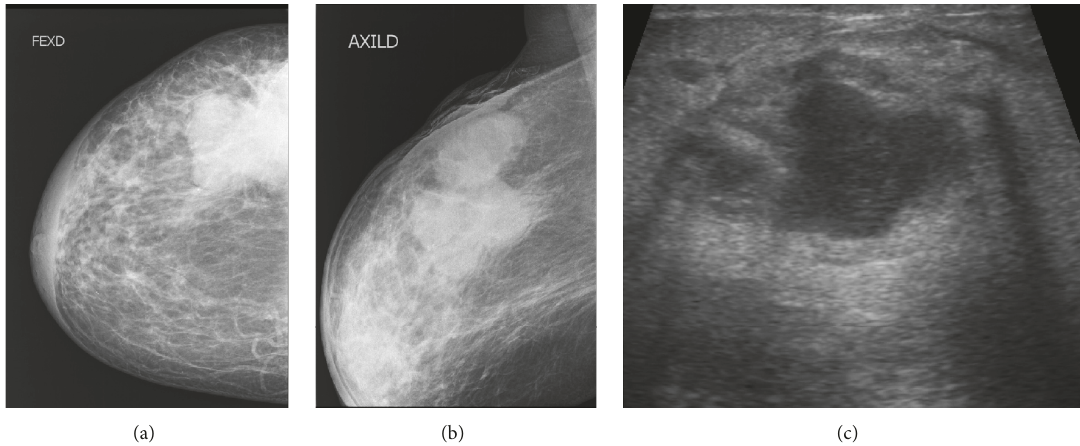
Figure 3: Mammogram images (a and b) presenting a mass with polylobed contours, associated with a small cluster of microcalcifications at 11 o’clock position of the right breast, with a thickening of the retroareolar skin facing the masse, which was confirmed as a hypoechoic mass with irregular and indistinct margins measuring approximately 4.6 cm in maximal diameter on ultrasound exam (c) (Collection of the Department of Radiology, University Teaching Hospital of Lom´e)